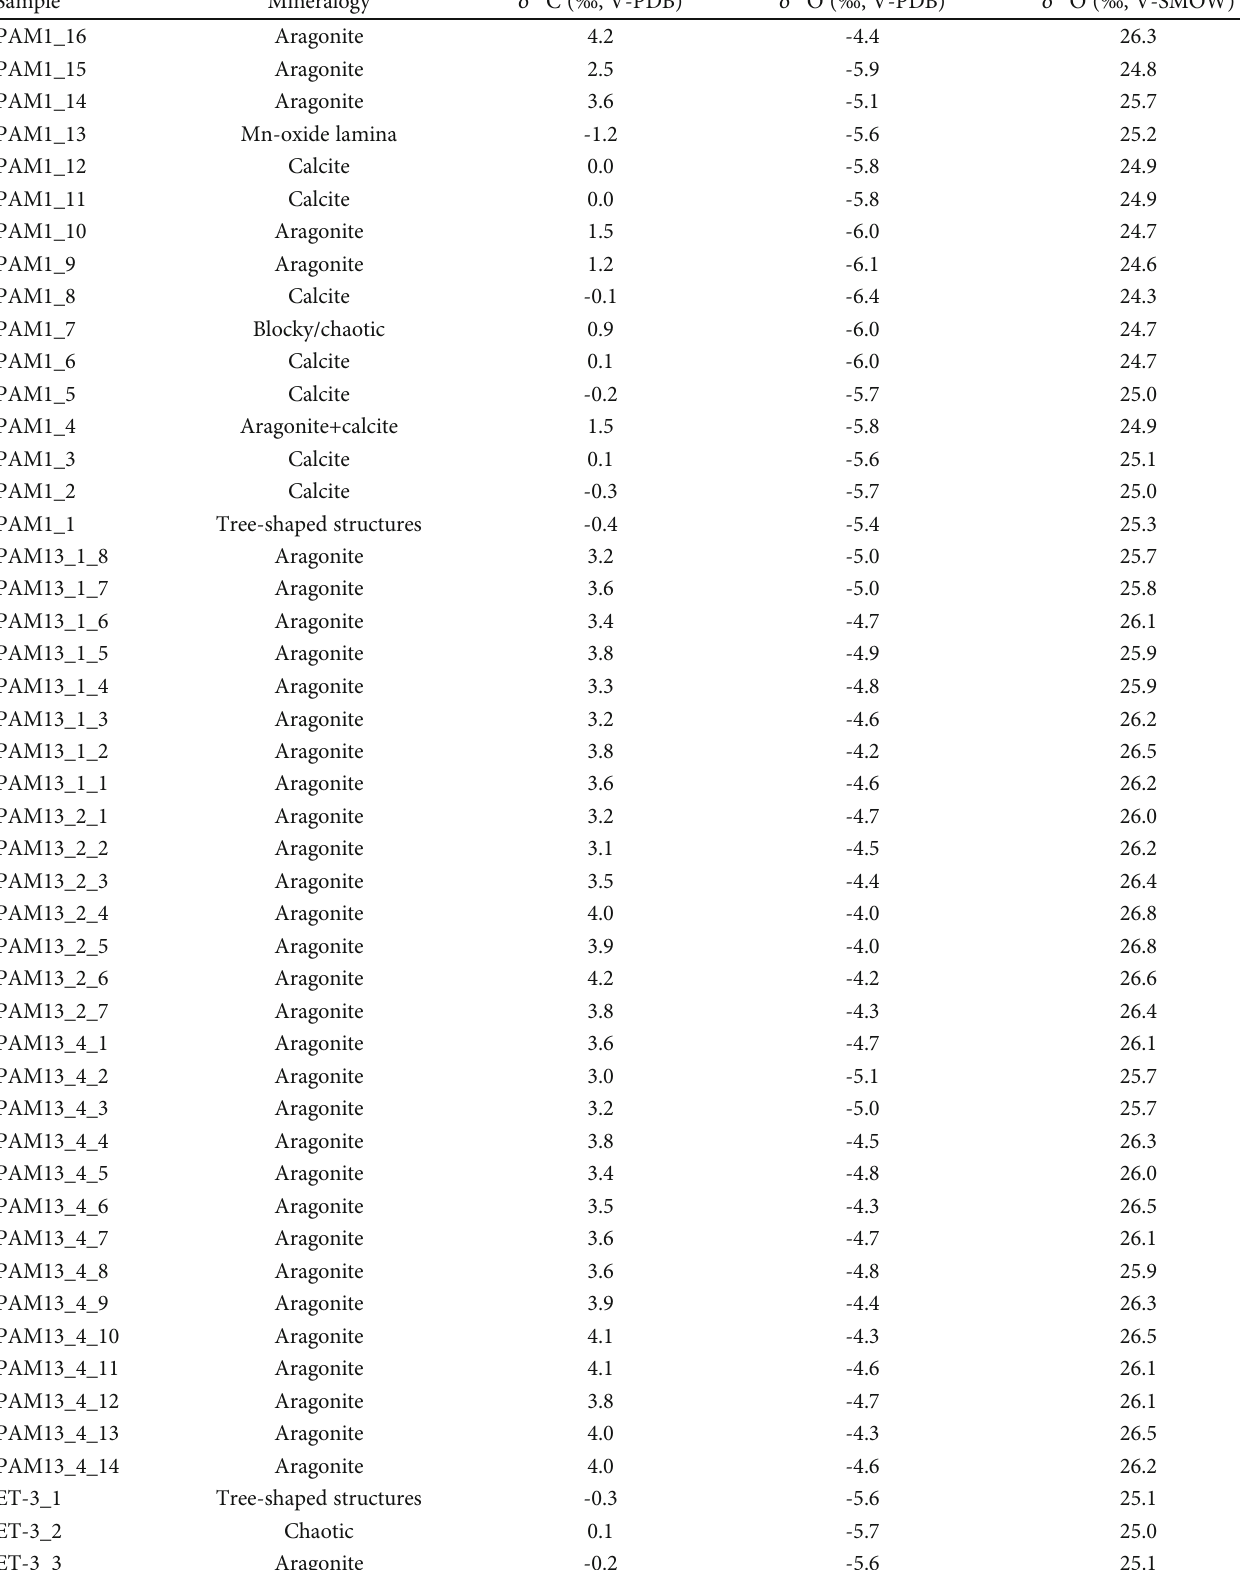
Table 4: Results of the stable isotopes